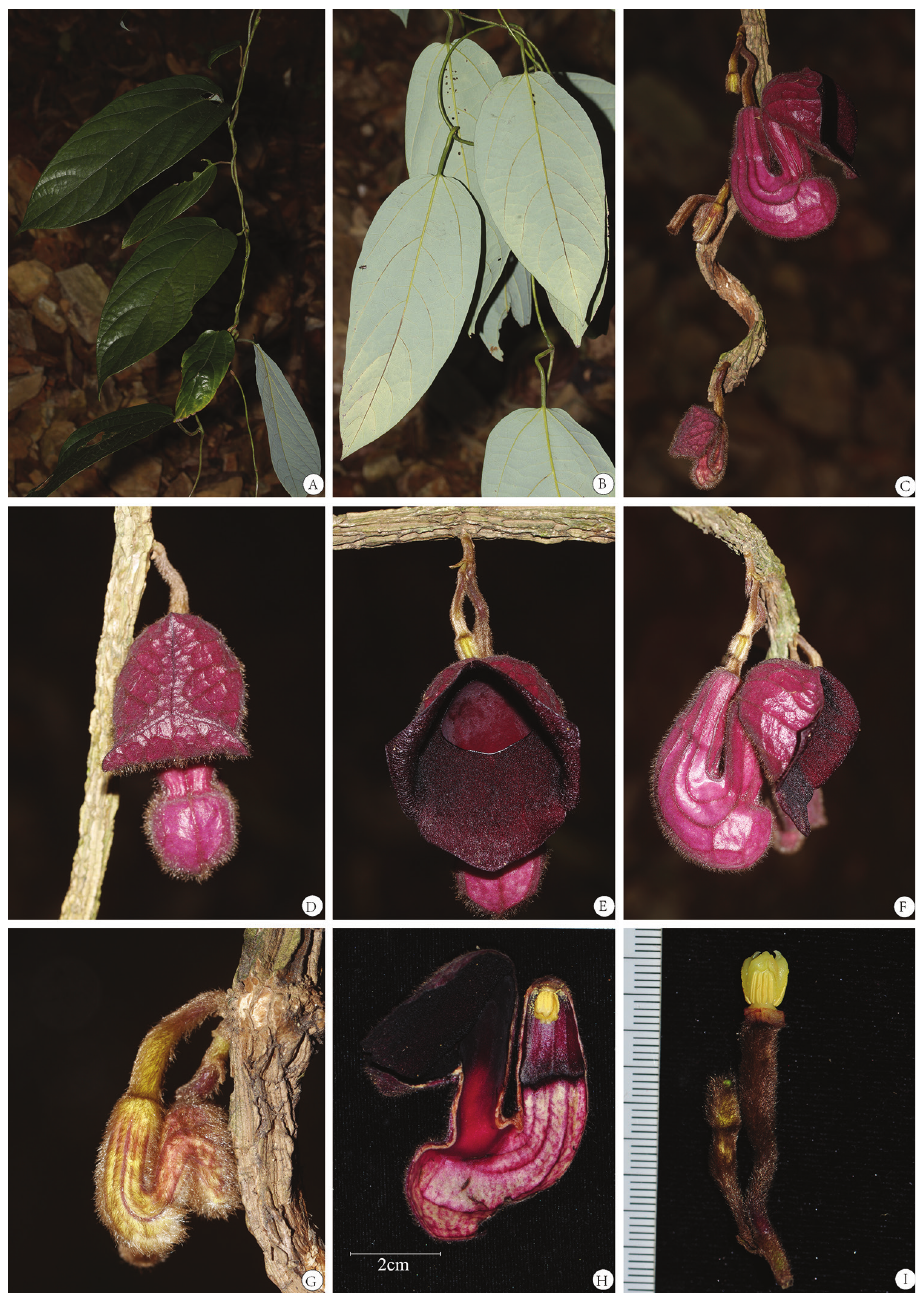
Figure 2. Aristolochia sinoburmanica Y.H.Tan & B.Yang, sp. nov. A young branch and adaxial leaf B young branch and abaxial leaf C cymes on old woody stems D front view of preanthesis flower E front view of open flower F lateral view of open flower G lateral view of young flower H longitudinal section of flower I gynostemium, ovary and pedicel. (Photographed by Y. H. Tan, H. B. Ding & B.